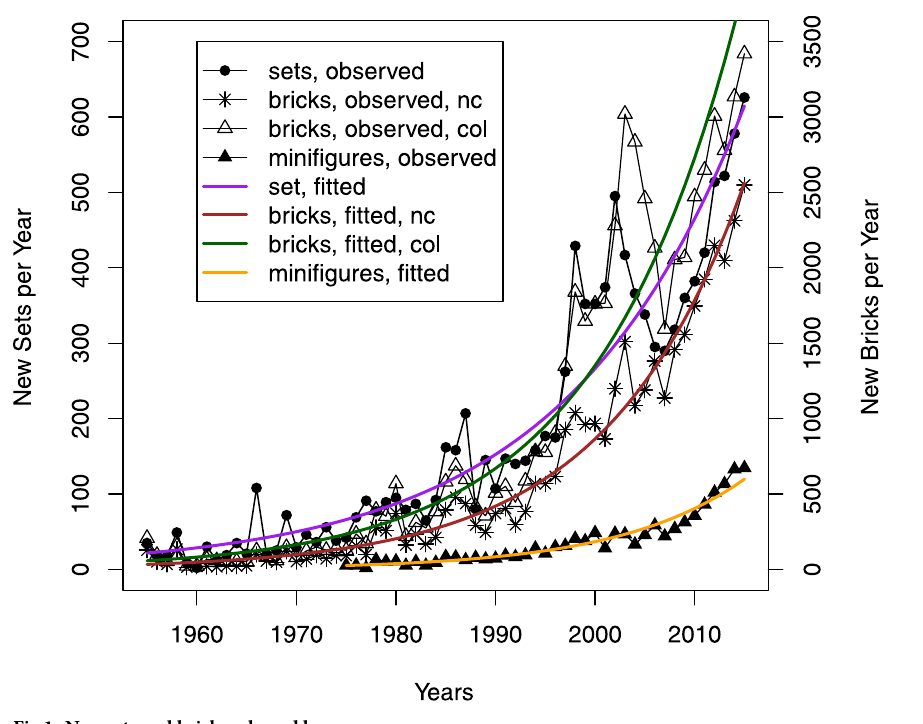
Fig 1. New sets and bricks released by